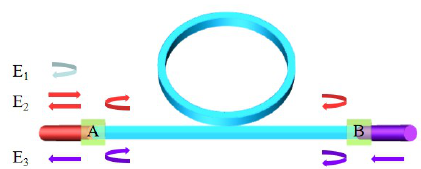
Figure 13. Conceptual diagram of the backreflection light in a reflective resonator.